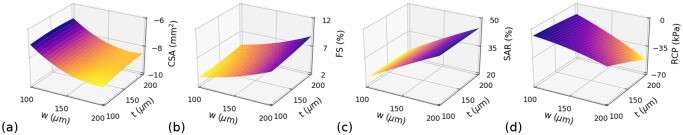
Response surfaces highlighting the combined influence of w and t on each performance metric (CSA, FS, SAR and RCP), holding Ar and l constant at their baseline values (Ar = 1.35 and l = 1050 μm).